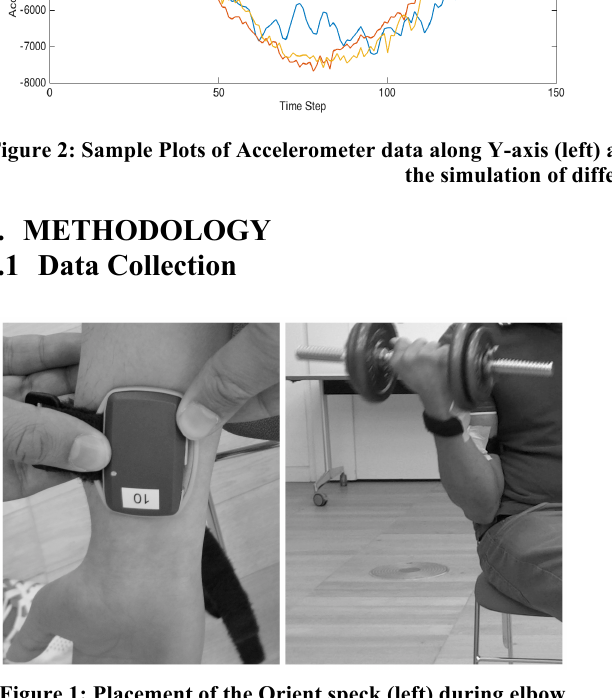
Figure 1: Placement of the Orient speck (left) during elbow flexion (right).